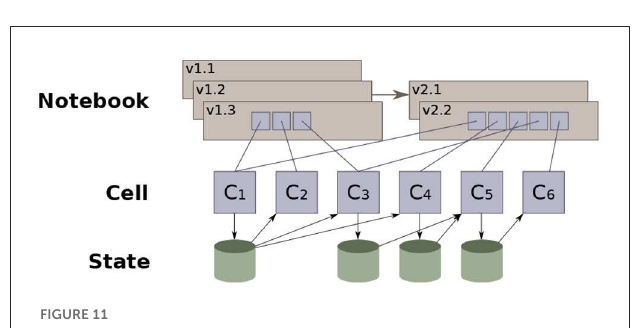
FIGURE11 Vizier’s notebook versioning data model